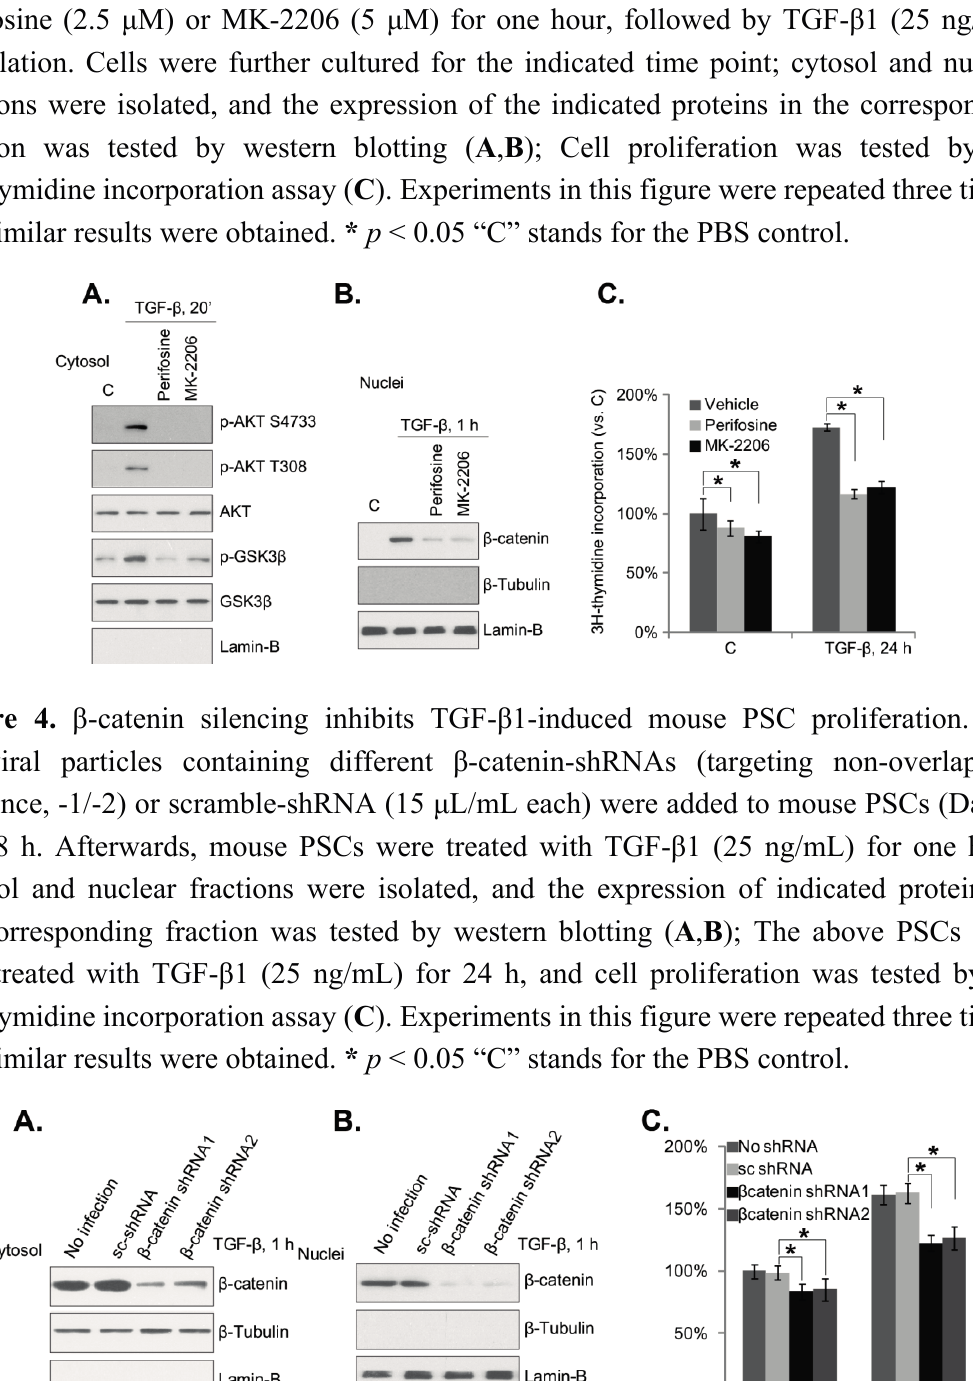
Figure 3. Akt blockers inhibit TGF- β 1-induced GSK3 β phosphorylation, β -catenin nuclear translocation and cell proliferation in mouse PSCs. Mouse PSCs were pre-treated with perifosine (2.5 μ M) or MK-2206 (5 μ M) for one hour, followed by TGF- β 1 (25 ng/mL) stimulation. Cells were further cultured for the indicated time point; cytosol and nuclear fractions were isolated, and the expression of the indicated proteins in the corresponding fraction was tested by western blotting ( A , B ); Cell proliferation was tested by the